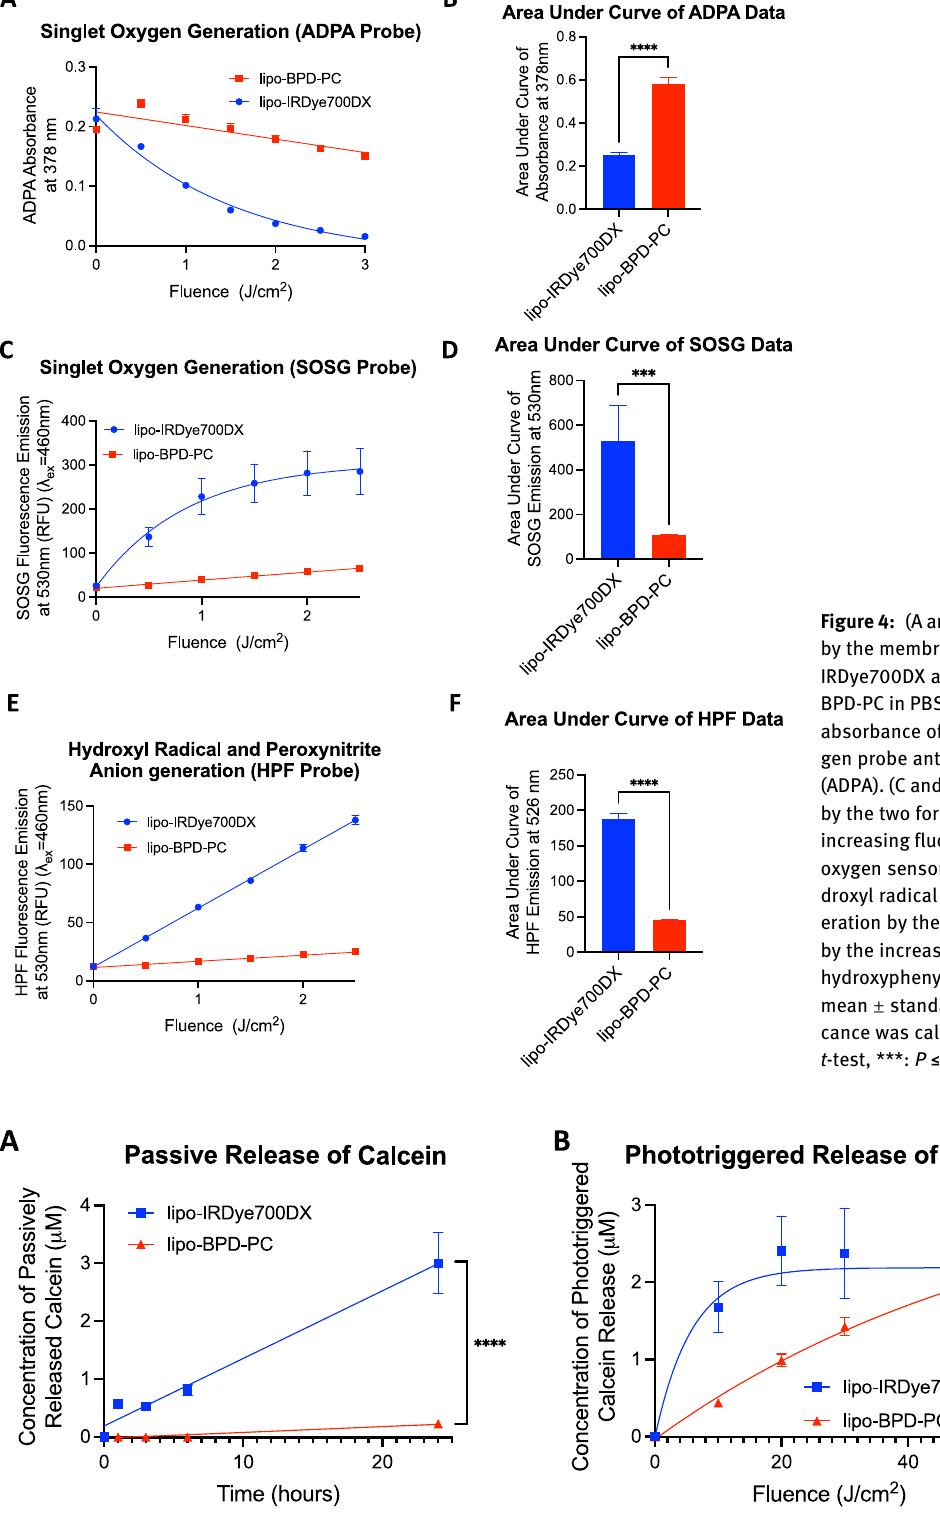
Figure 5: Phototriggered (A) and passive (B) calcein release from lipo-IRDye700DX and lipo-BPD-PC. Phototriggered calcein release was performedusing690nmlightatanirradianceof17.86mWcm − 2 (Dataaremean ± standarderror;statisticalsigni fi cancewascalculatedusing one-way ANOVA with a Tukey post-test, ***: P < 0.001; ****: P <